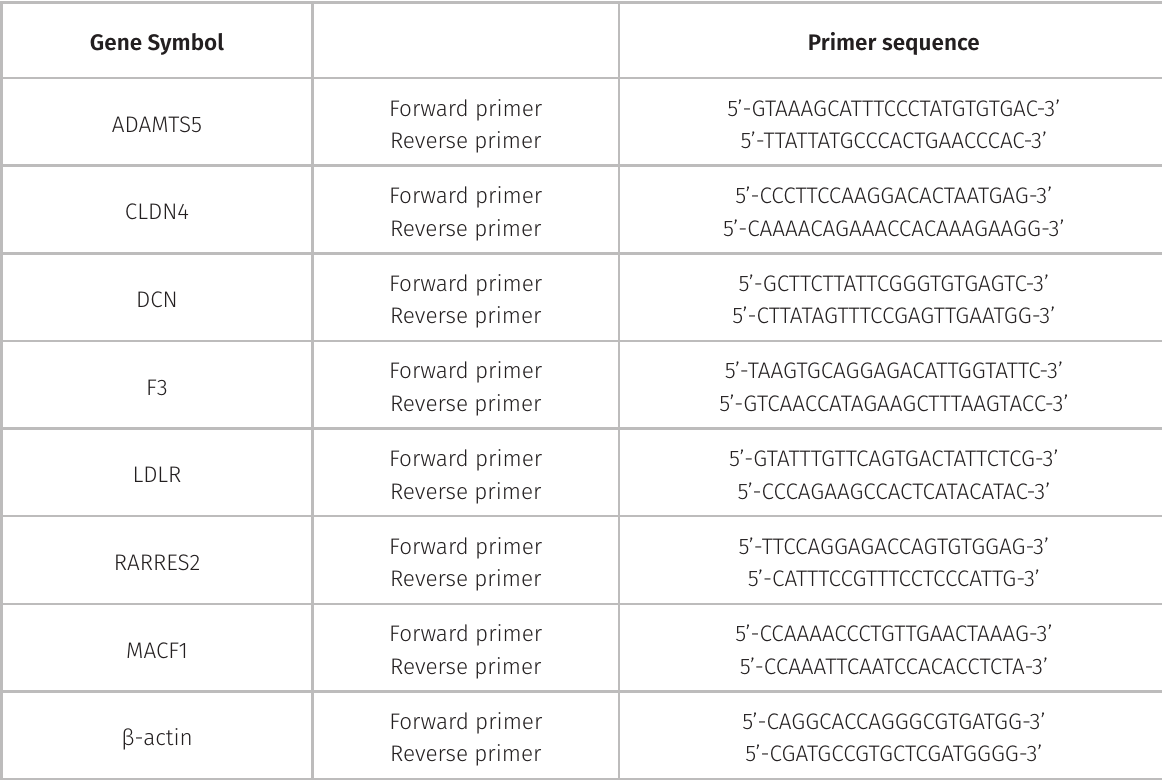
Table I. List of primers used for the detection of ADAMTS5, CLDN4, DCN, F3, LDLR, RARRES2, MACF1 and β-actin by SYBR Green